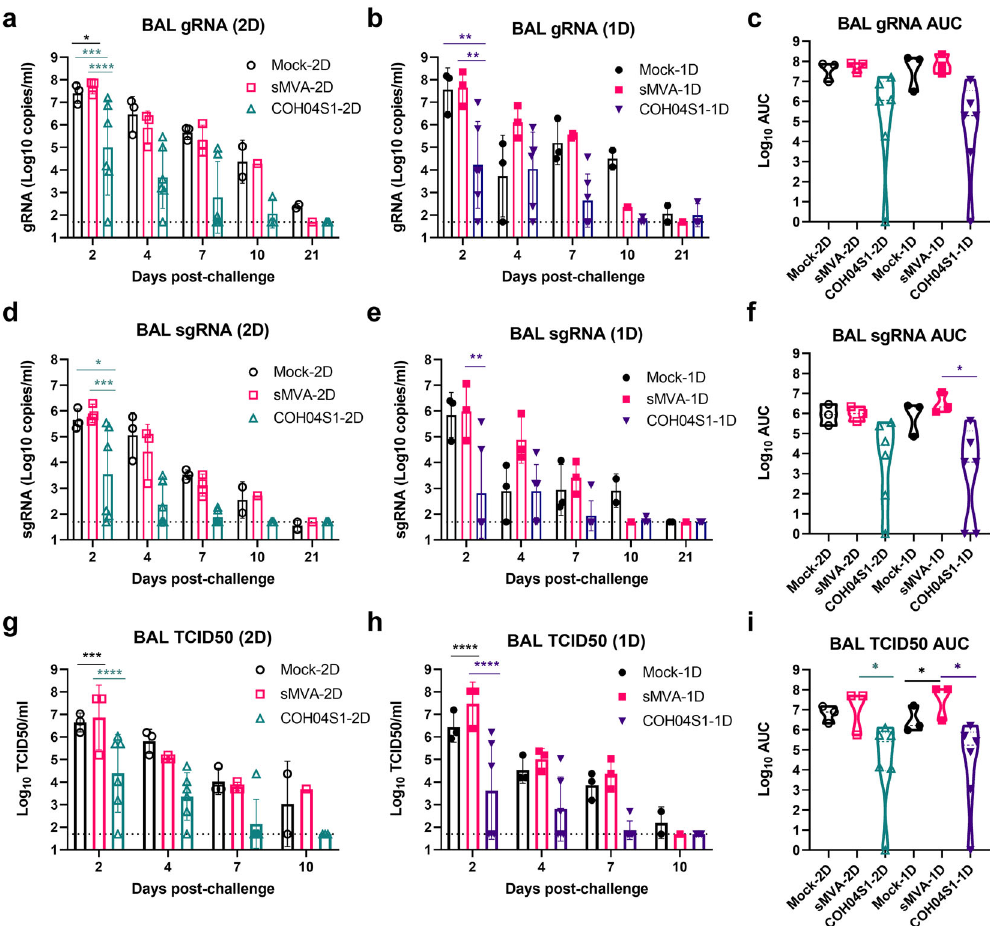
Fig. 4 BAL viral loads in COH04S1-vaccinated NHP following SARS-CoV-2 challenge. SARS-CoV-2 genomic RNA (gRNA; a – c ) and subgenomic RNA (sgRNA; d – f ) copies and TCID50 infectious virus titers ( g – i ) were measured at the indicated days post challenge in bronchoalveolar lavages (BAL) of COH04S1-2D and COH04S1-1D-vaccinated NHP and mock-vaccinated and sMVA vector control animals. Bars represent geometric means, lines represent ±geometric s.d. Dotted lines represent lower limit of detection. Two-way ANOVA followed by Sidak ’ s multiple comparison test was used. Panels c , f , and i show viral loads by area under the curve (AUC). Violin plots show value ranges with median values (dashed line) and quartiles (dotted line). AUC = 0 was indicated as 1. One-way ANOVA followed by Tukey ’ s multiple comparison test was used. *0.05 < p < 0.01, **0.01 < p < 0.001, ***0.001 < p < 0.0001, **** p <